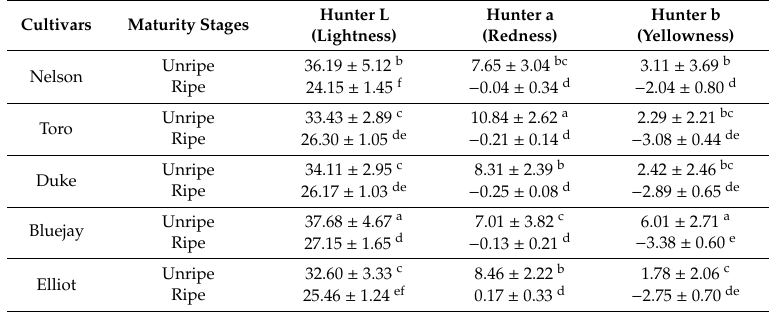
Table 1. Hunter L, a, b color of blueberry fruits at di ff erent maturity stages.